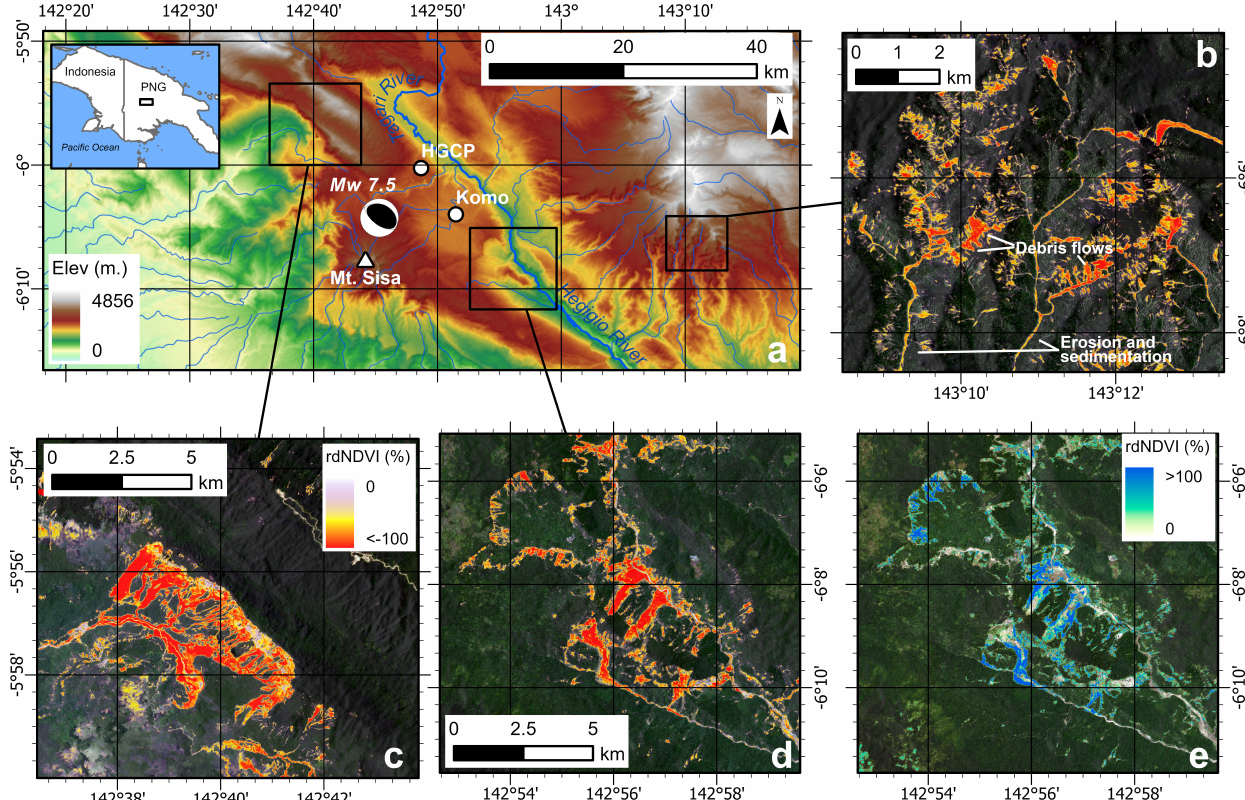
Figure 4. rdNDVI change detection images and greenest-pixel composites following a landsliding event triggered by the M w 7.5 earthquake on 26 February 2018 in the Southern Highlands of Papua New Guinea (PNG). Inset map shows location within the country. Parameters for (a–d) – dataset: Sentinel-2; event date: 25 February 2018; pre-window: 12 months; post-window: 9 months; maximum cloud cover: 30%; slope threshold: 0.05 ◦ . (a) Elevation map for the Southern Highlands of PNG with epicenter (focal mechanism) plotted. HGCP is Hides Gas Conditioning Plant, an ExxonMobil liquefied natural gas facility. Komo is the nearest large town, and Mt. Sisa is a stratovolcano to the south. (b–d) Select areas with high mass-wasting density. Base images are the pre-event greenest-pixel composite, and (b–d) have the same rdNDVI color scale. (e) Recovery change detection image illustrating increases in vegetation within areas of previous mass wasting. These increases in vegetation are expected to increase root mass and provide a stabilizing effect for exposed soils. Parameters – dataset: Sentinel-2; event date: 26 August 2018; pre-window: 6 months; post-window: 6 months; maximum cloud cover: 30%; slope threshold: 0.05 ◦ . rdNDVI and greenest-pixel composite data exported from HazMapper, available at https://go.ncsu.edu/hazmapper-png (last access: 29 April